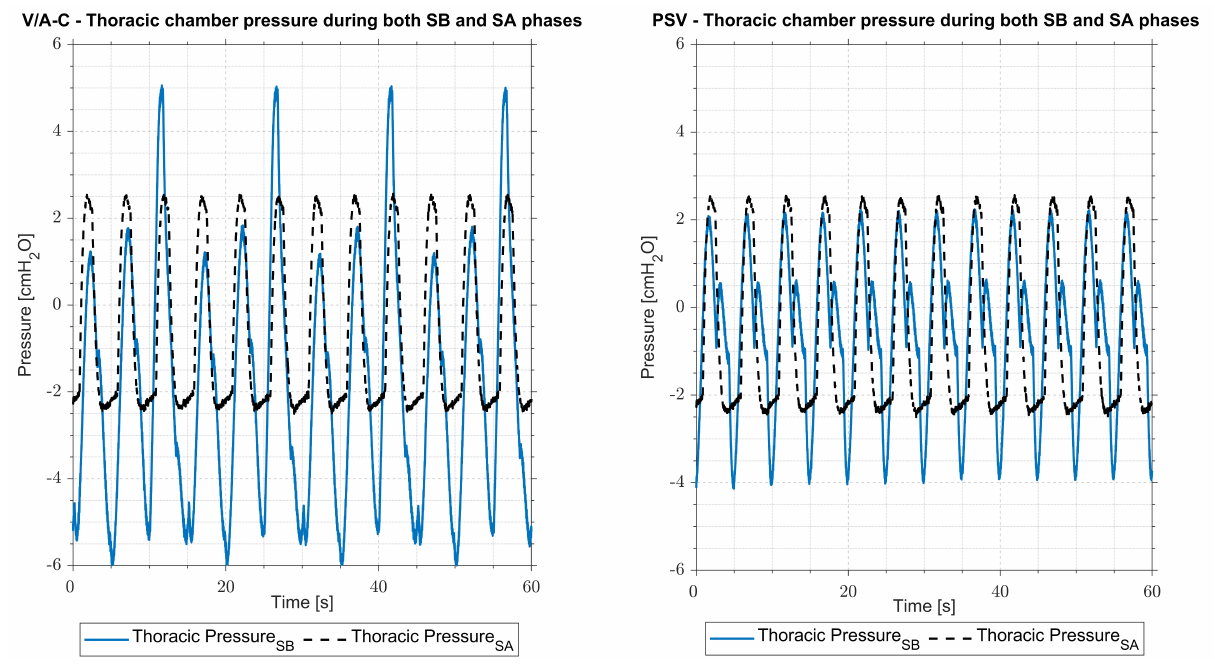
Figure 6. Pressure changes in the thoracic chamber of the xPULM™ recorded during Phase 1—spontaneous sinusoidal breathing (SB), blue solid line and Phase 2—simulated apnea (SA), black dashed line in the V/A-C mode ( left ) and in the PSV mode ( right ). The changes in peak pressure (>4 cmH 2 O, left ) and occurrence of premature cycling at every breath ( right ) indicate asynchrony events during mechanical ventilation and correspond to the data recorded by the